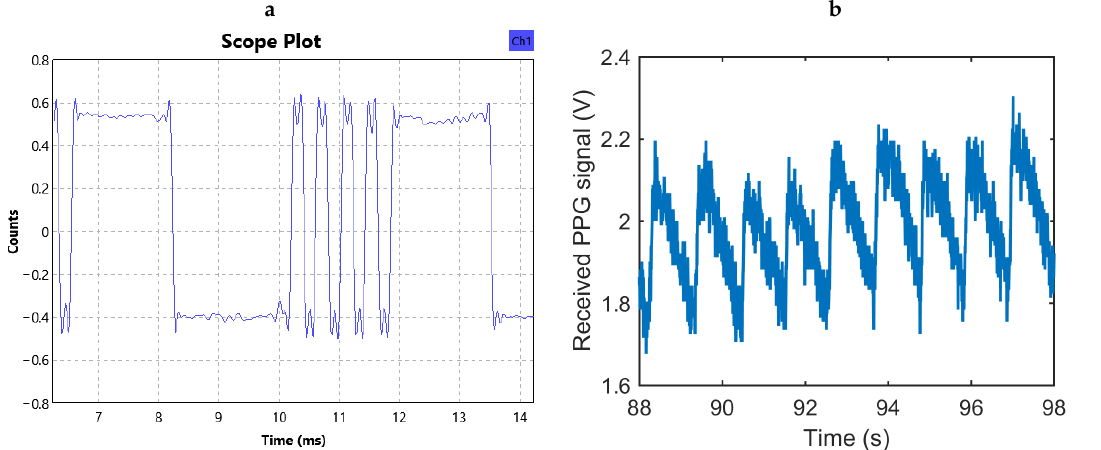
Figure 13. ( a ) An excerpt of the received data stream after being demodulated and low-pass filtered in the SDR. ( b ) Received PPG waveform collected from the human finger after extracting the 8-bit samples from the serial data stream.